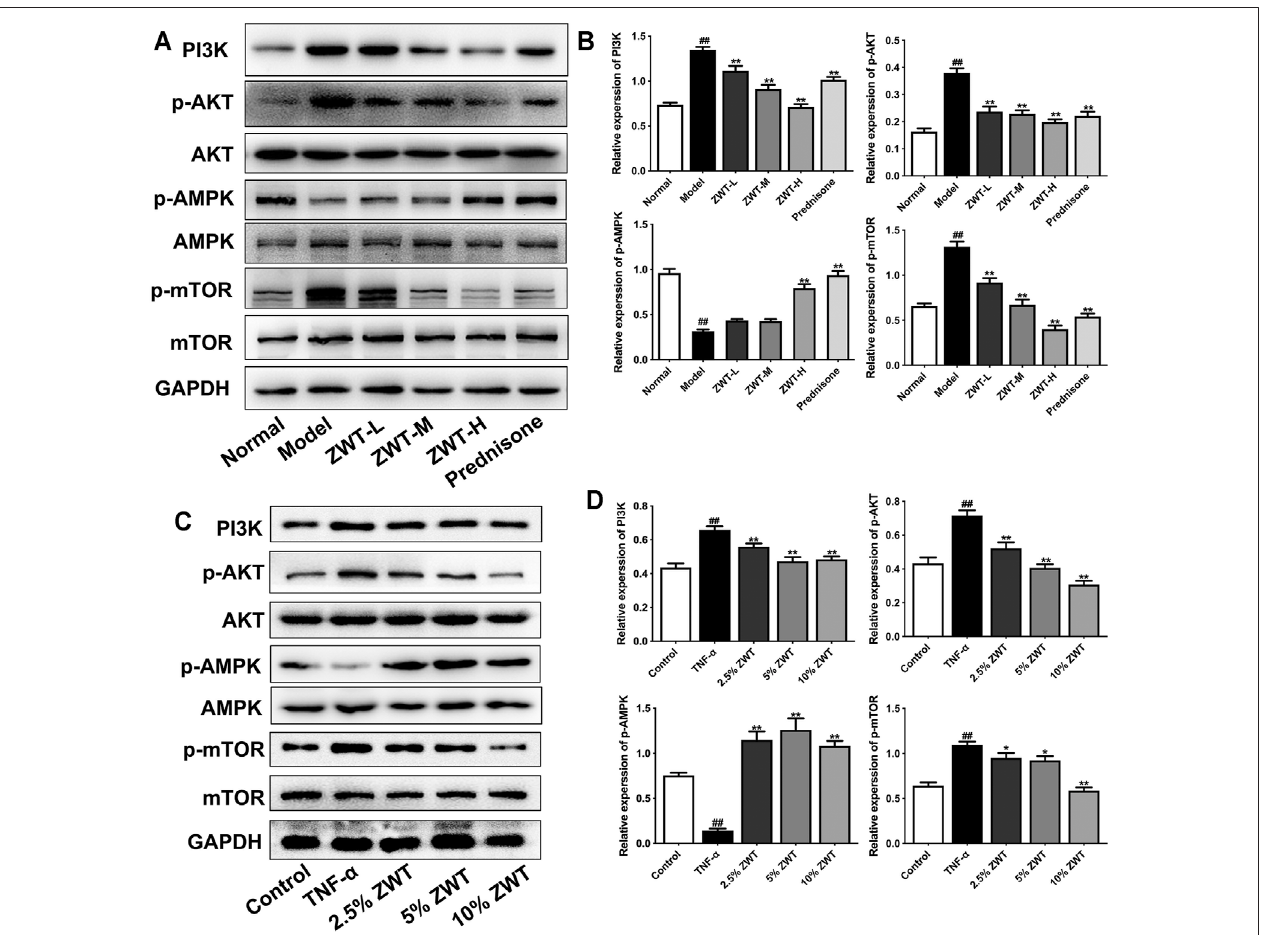
FIGURE 7 | ZWT regulated the phosphatidylinositol 3-kinase (PI3K)/AKT/mTOR and AMPK pathways in CGN. (A,B) The protein blots and quantitative analysis of PI3K,p-AKT,p-AMPK,andp-mTORinrenaltissue. (C,D) TheproteinblotsandquantitativeanalysisofPI3K,p-AKT,p-AMPK,andp-mTORinpodocytes.Theobtained values of PI3K were normalized to GAPDH, p-AKT values were normalized to AKT, p-AMPK values were normalized to AMPK, and p-mTOR values were normalized to mTOR.Dataarerepresentedasmean ± SD( n (cid:2) 3). # p < 0.05, ## p < 0.01versusnormalorcontrolgroup,* p < 0.05and** p < 0.01versusthemodelgrouporTNF- α group. The intervention of PI3K inhibitor and agonist against